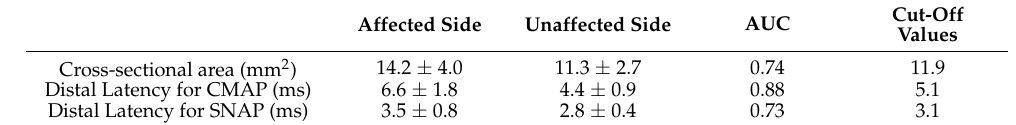
Table 2. Results obtained for each parameter.